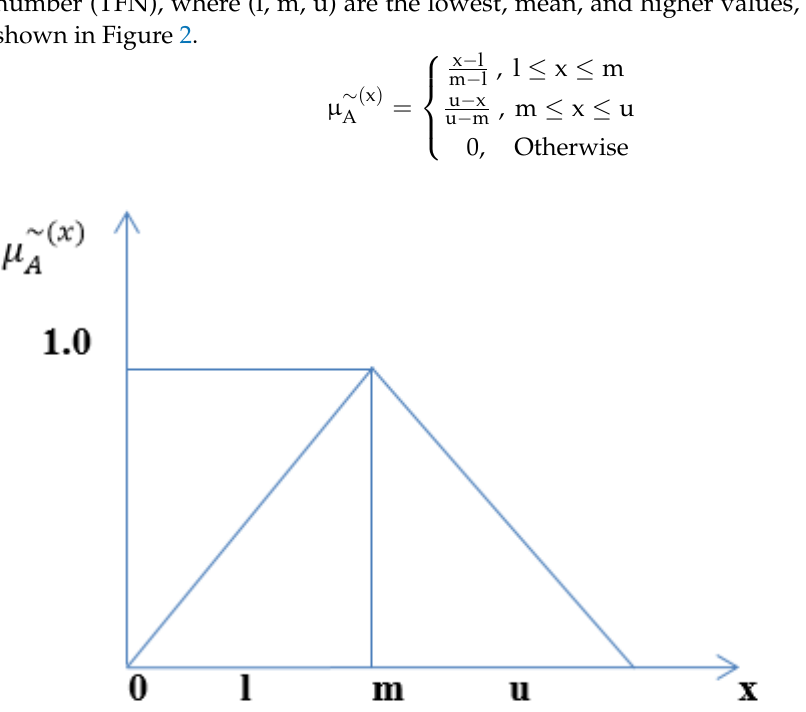
Figure 2. The triangular fuzzy number’s Function of Membership.